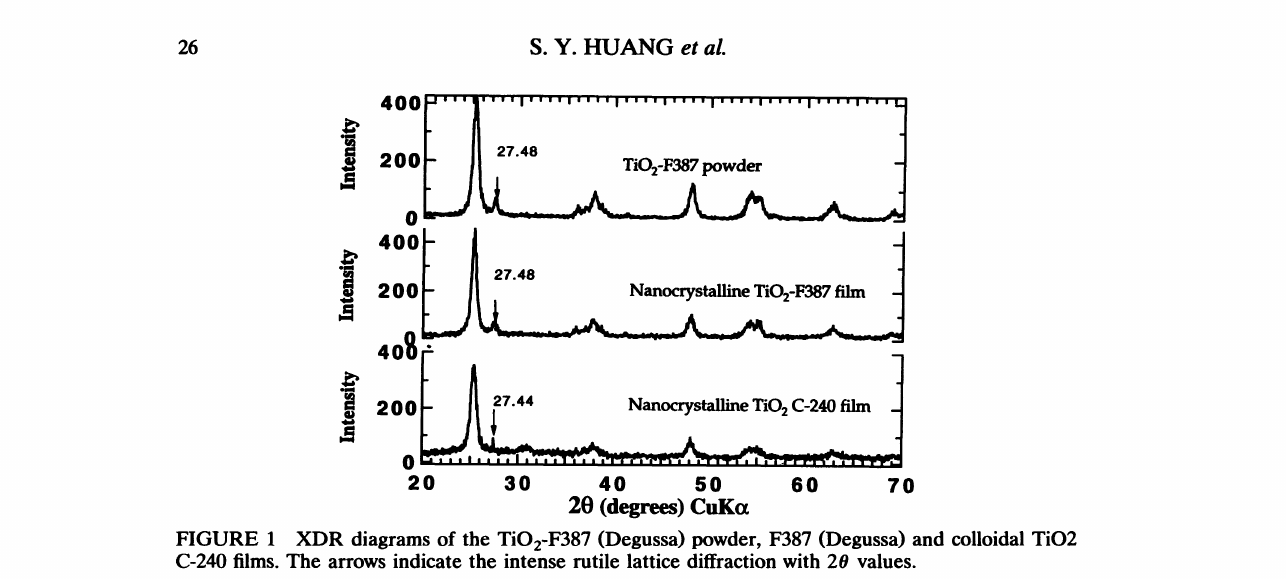
XDR diagrams of the TiO2-F387 (Degussa) wder, F387 (Degussa) and colloidal TiO2 C-2 films. The aows indicate the intense tile lattice diffraction with 20 values. proportion of anatase to rutile. There is no obvious change of the XRD spectra between powder and sintered layers. The film of TiO2-colloid presents practically pure anatase phase.